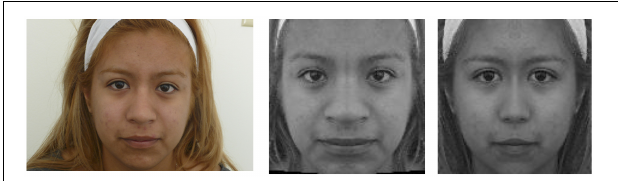
FIGURE 1 | Left : original face image from our dataset. Middle : a perfectly symmetrical face made of the left half of the original face. Right : a perfectly symmetrical face made of the right half of the original